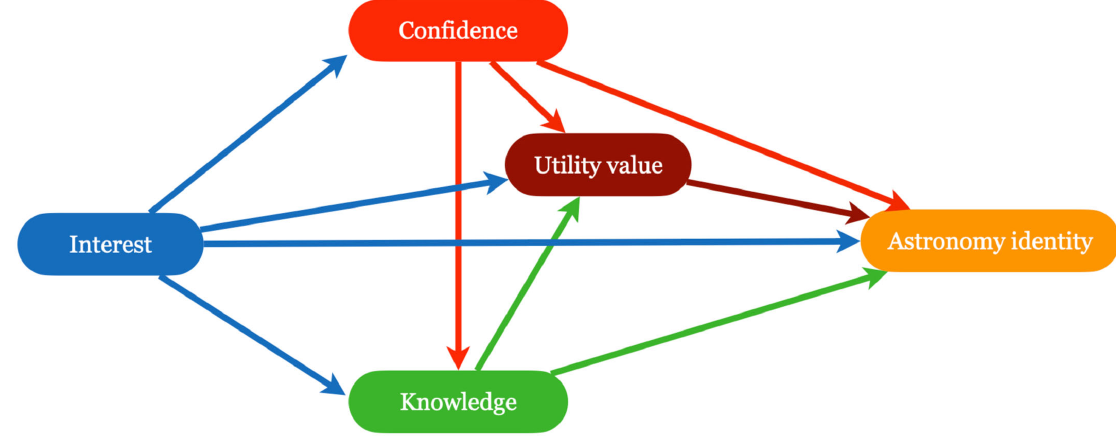
FIG. 1. Model of astronomy identity framework. Arrows represent the hypothesized paths.